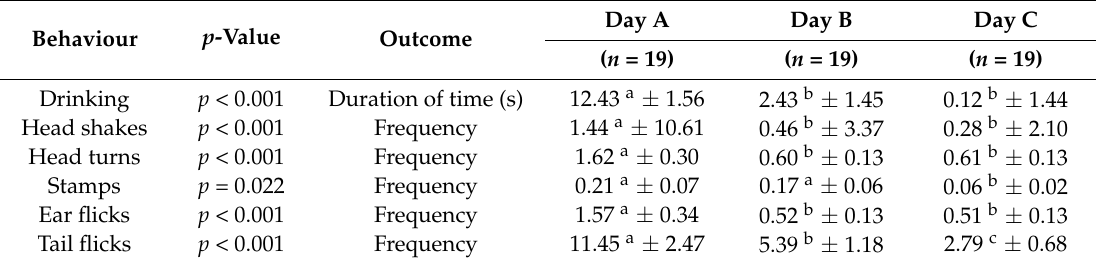
Table 6. Mean duration of time (s) spent drinking and mean frequency of head shakes, head turns, stamps, ear flicks and tail flicks displayed by calves ( n = 57) on each day within a 5-min focal